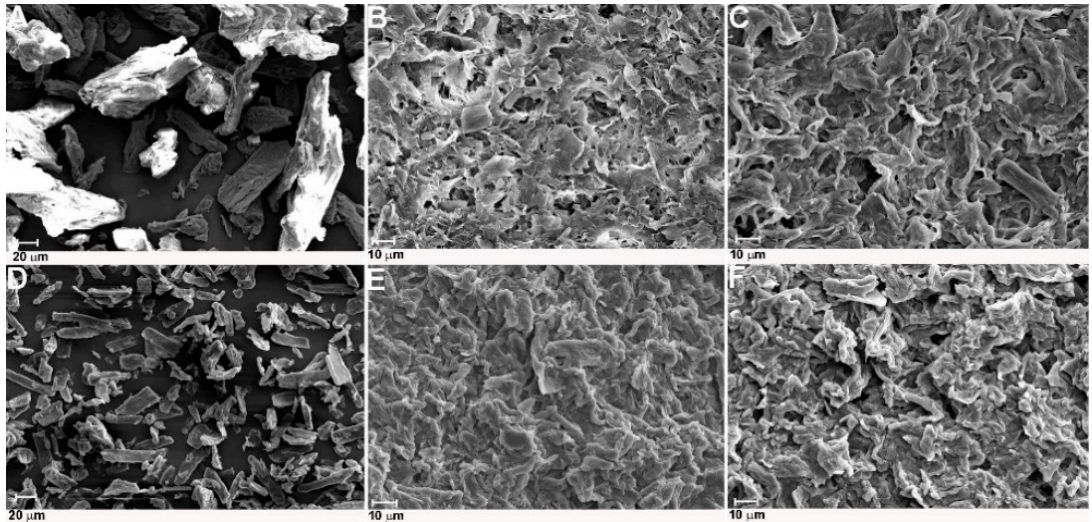
Figure 5. SEM images of ( A ) Avicel, ( B ) Avicel treated with [EMIM][Cl], ( C ) Avicel treated